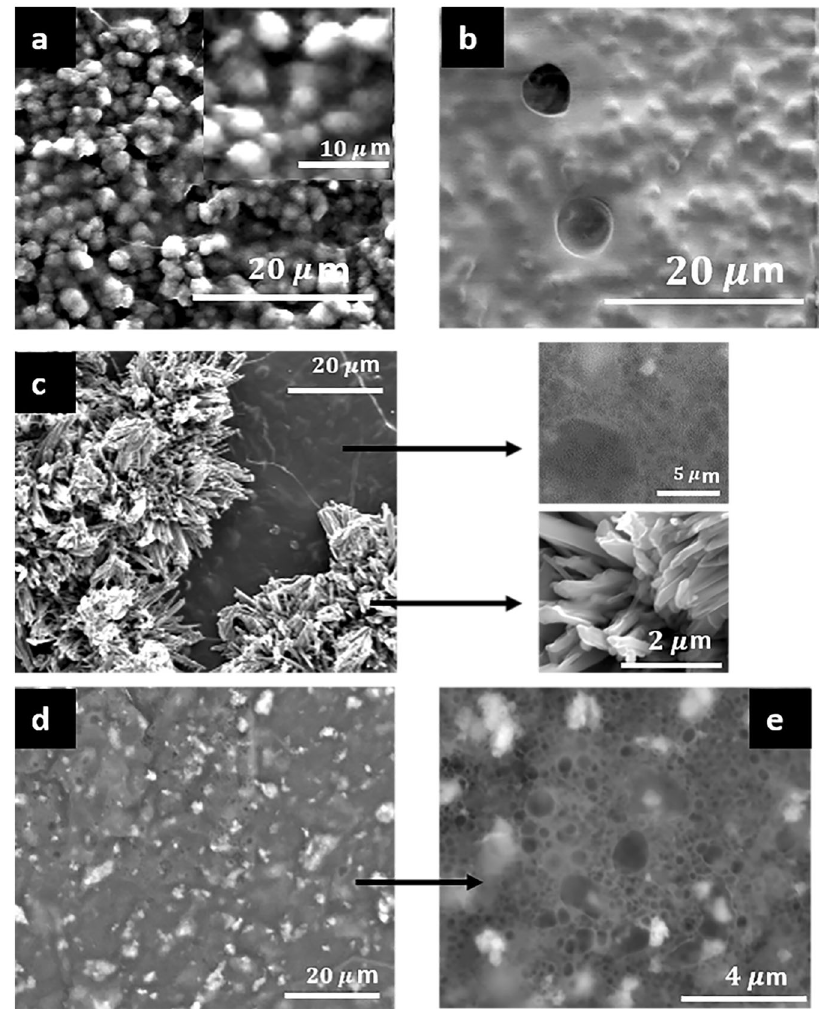
Fig. 6 SEM Images of the different tri-composite (Cs/Col/ HA) membranes: a TC1. b TC3. c TC2. d , e TC4. insets in c are magni fi ed regions of the matrix